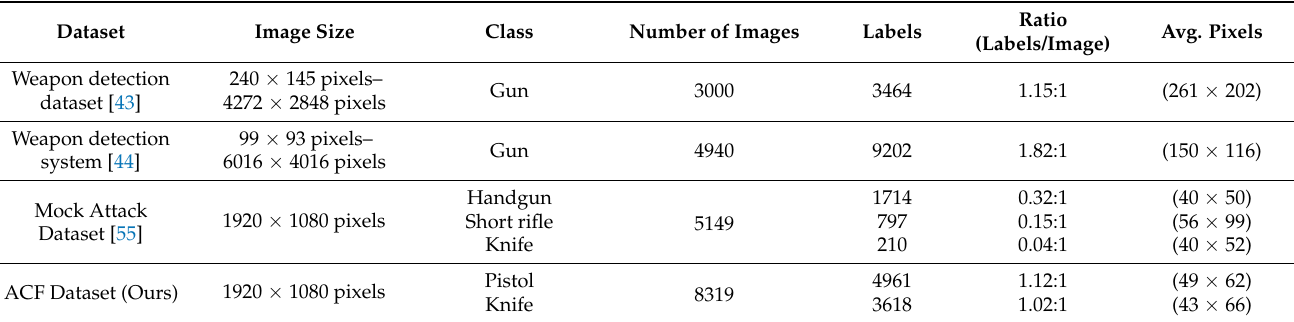
Table 1. Public dataset